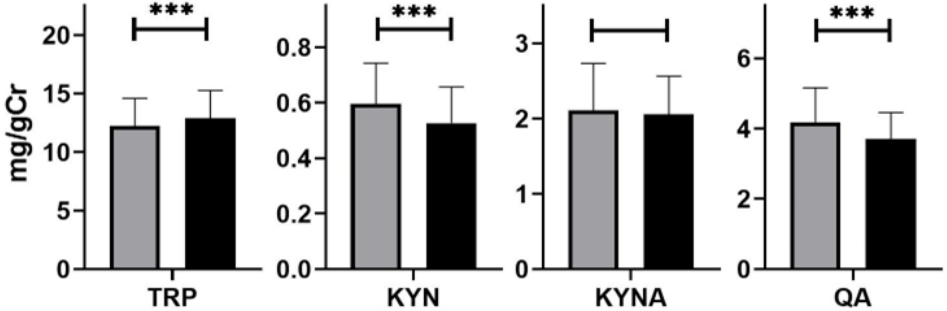
Figure 4. Urinary excretion of tryptophan (TRP) and its metabolites: kynurenine (KYN), kynurenic acid (KYNA), and quinolinic acid (QA) before (grey) and after (black) treatment with rifaximin. Differences were examined by Wilcoxon signed rank test; n = 40 in both groups; *** p < 0.001. Similarly, the tryptophan metabolite ratios also changed favorably after rifaximin treatment: KYN/TRP decreased from 0.048 ± 0.01 to 0.04 ± 0.01 ( p < 0.05), KYN/QA in- creased from 0.53 ± 0.21 to 0.57 ± 0.17 ( p < 0.01); while KYN/KYNA had changed slightly, this was from 3.71 ± 1.38 to 4.22 ± 0.91 ( p = 0.099, Figure 5). Figure 5. Ratios of tryptophan (TRP) and its metabolite levels (mg/gCr): kynurenine (KYN), kynurenic acid (KYNA), quinolinic acid (QA) in patients with small intestinal bacterial overgrowth before (grey) and after (black) rifaximin treatment. Differences were examined by Wilcoxon signed rank test; n = 40; * p < 0.05, ** p < 0.01. After rifaximin treatment, the severity of abdominal symptoms decreased from 37.5 ± 3.76 points to 20.6 ± 3.62 points ( p < 0.001, Figure 6). Diarrhoea resolved in 33 (82.5%) patients, abdominal pain in 32 (80.0%), bloating in 27 (67.5%), and flatulence in 26 (65.0%). There was also a reduction in depression symptoms from 15.5 ± 3.41 points to 10.2 ± 2.97 points ( p < 0.001, Figure 5). However, in eight (20.0%) the mental mood, especially anxiety, continued. Rifaximin was well tolerated, but six (15.0%) patients experienced increased bloating and flatulence on certain treatment days.